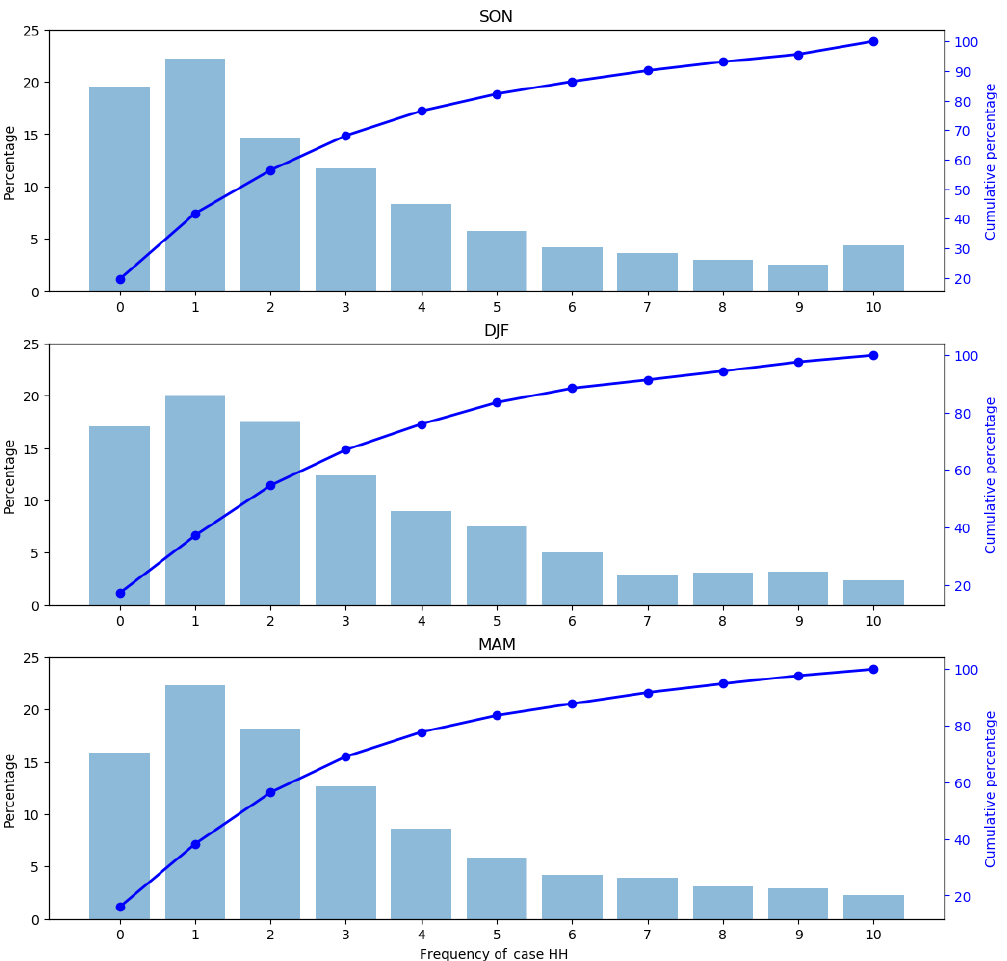
Figure 7. As for Fig. 5 but for SON, DJF, and